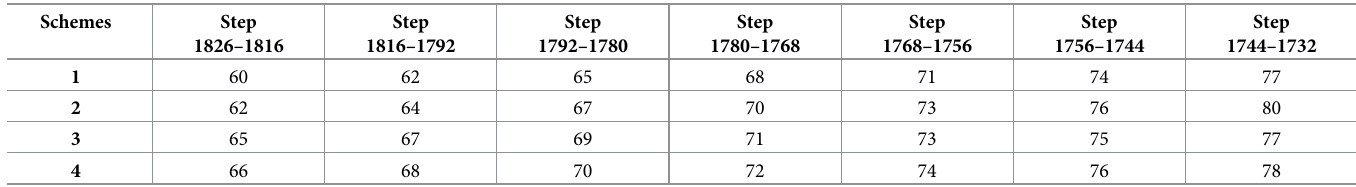
Table 3. The parameters of excavation slope angle in the experimental scheme (˚).